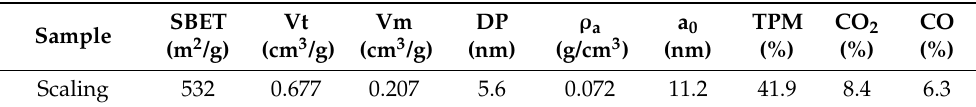
Table 5. Structural properties of the sample synthesized in the scaling process and reductions for TPM, CO and CO 2 obtained in the smoking experiment carried out.